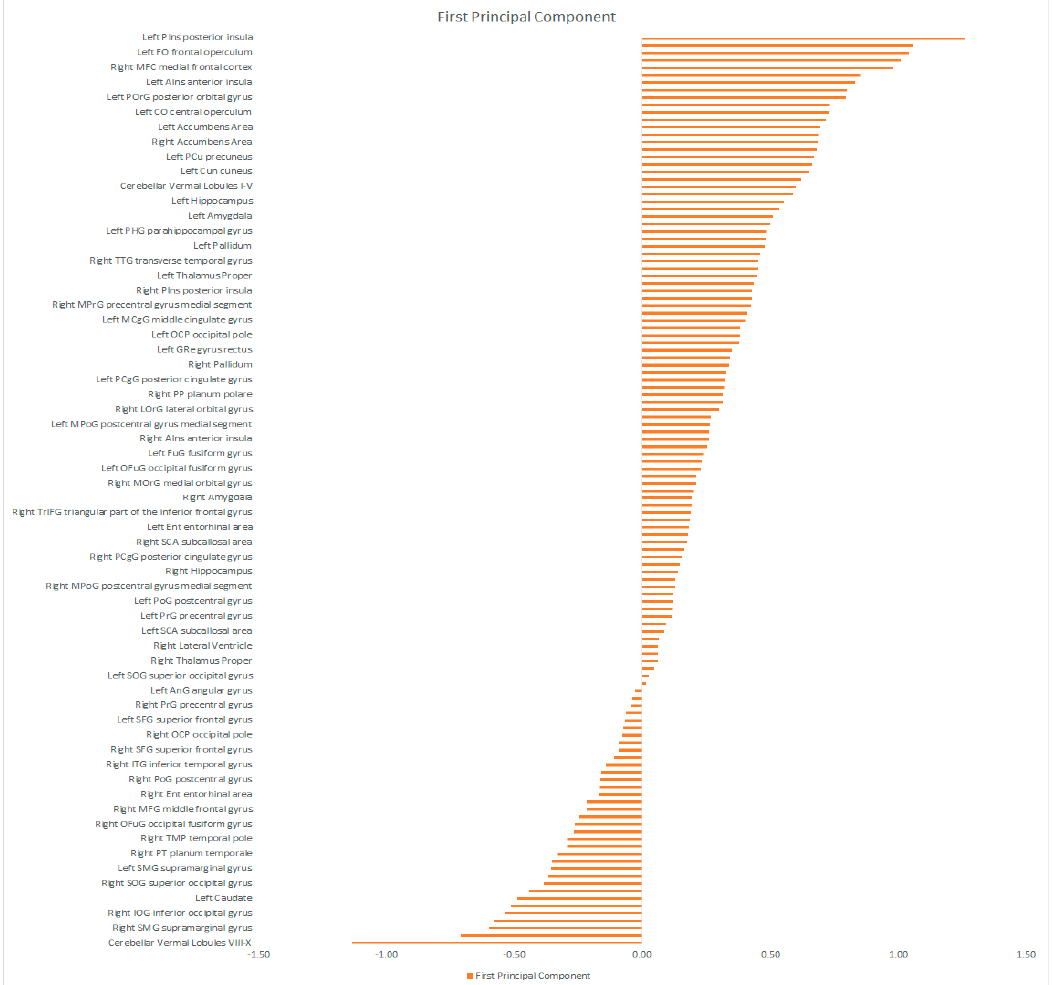
Figure 4. The bars plot shows the average contribution for the first component/Eigenimage computed at the regional level using the Neuromorphometric atlas. The higher the value, the higher the contribution positively or negatively.